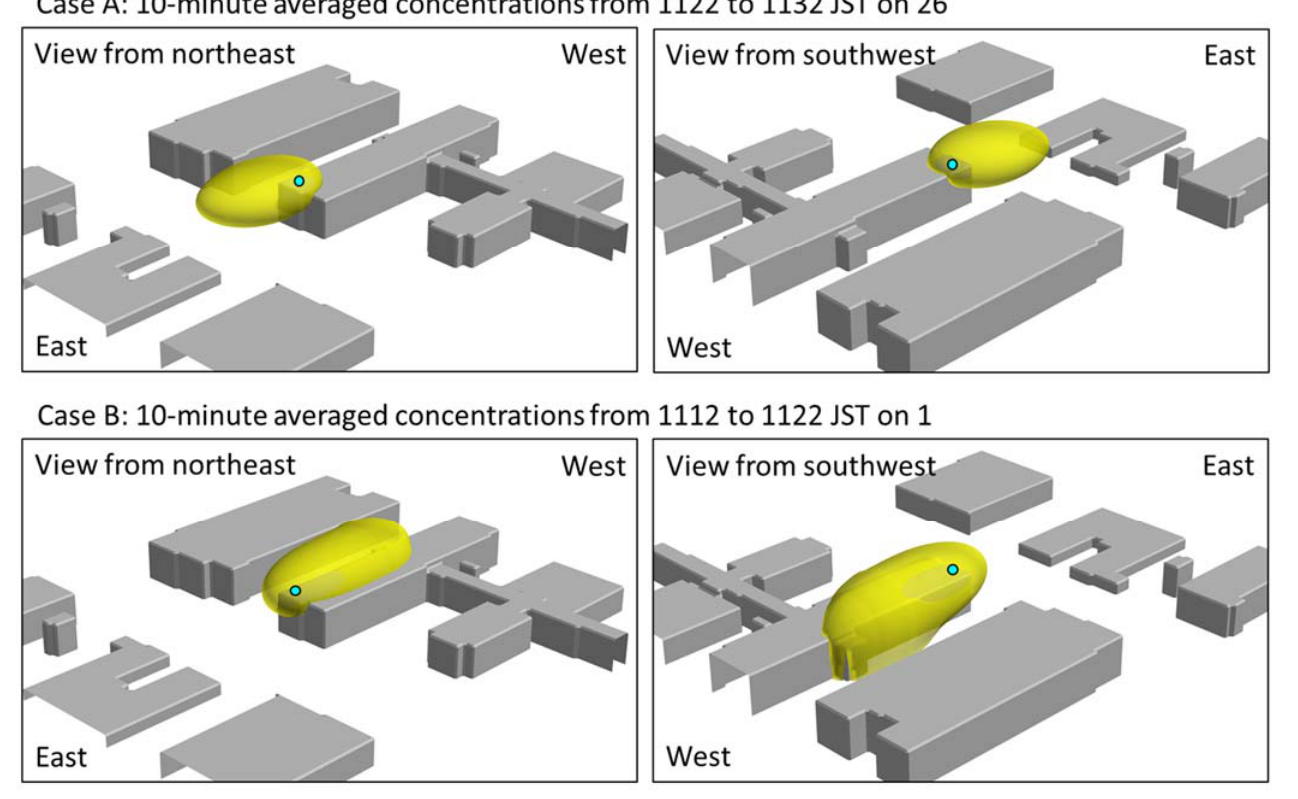
Figure 10. 10-min averaged concentrations of the simulated plume. The yellow areas indicate the 5% iso-surface of initial concentration. The blue circle is the release point.